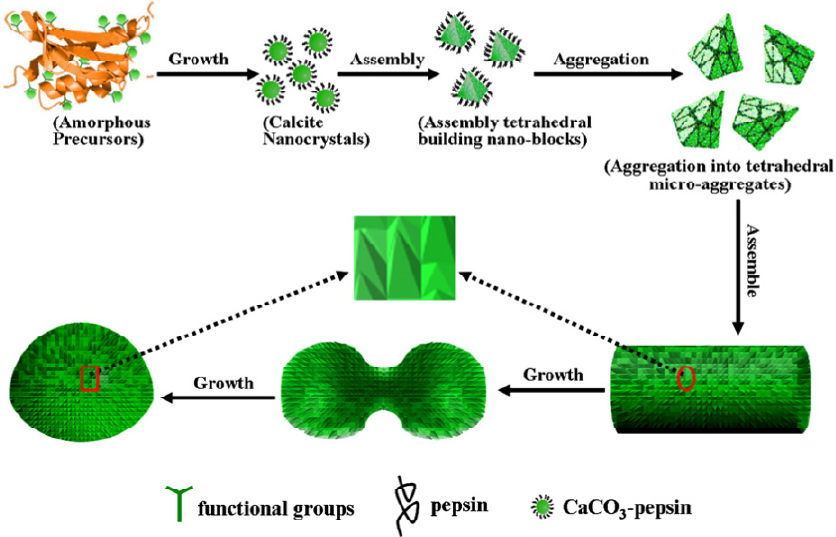
Figure 20. Mechanism of the formation of hierarchical structures of CaCO amorpuus precursors. Reprinted with permission from [255]. Copyright 2012